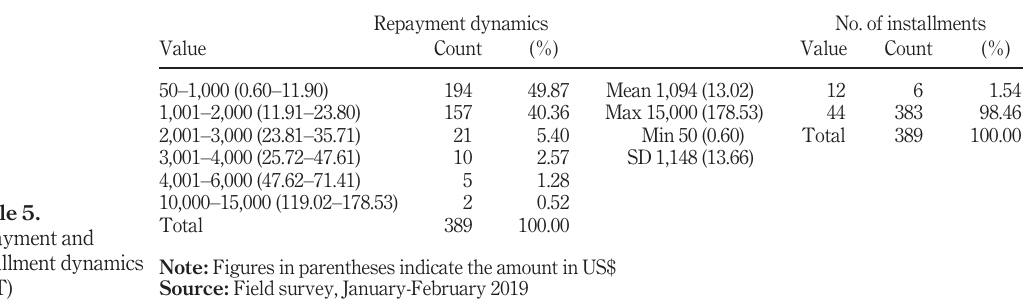
Table 5. Repayment and installment dynamics